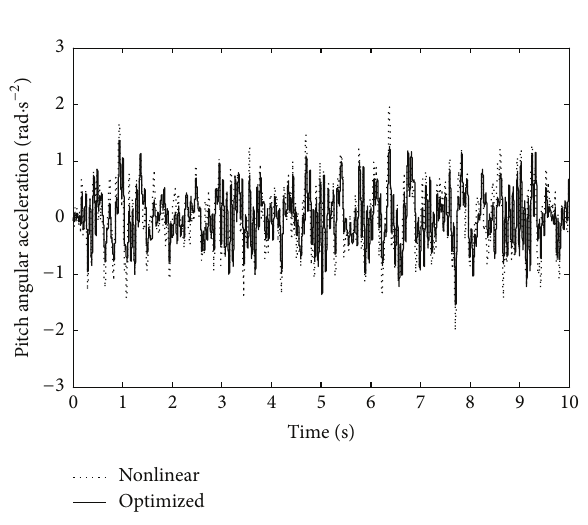
Figure 9: Vertical body acceleration.